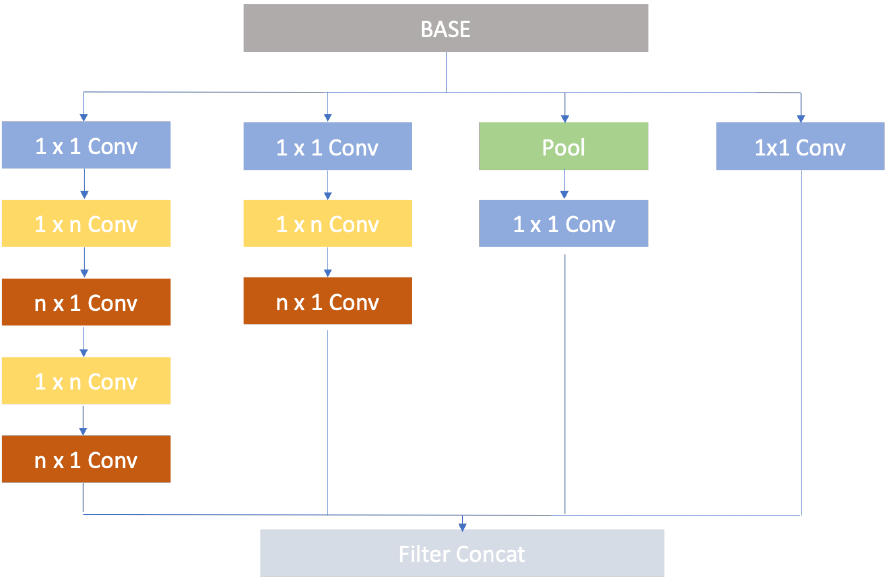
Figure 3. Graphical representation of the inception module constituent component of the Inception network.